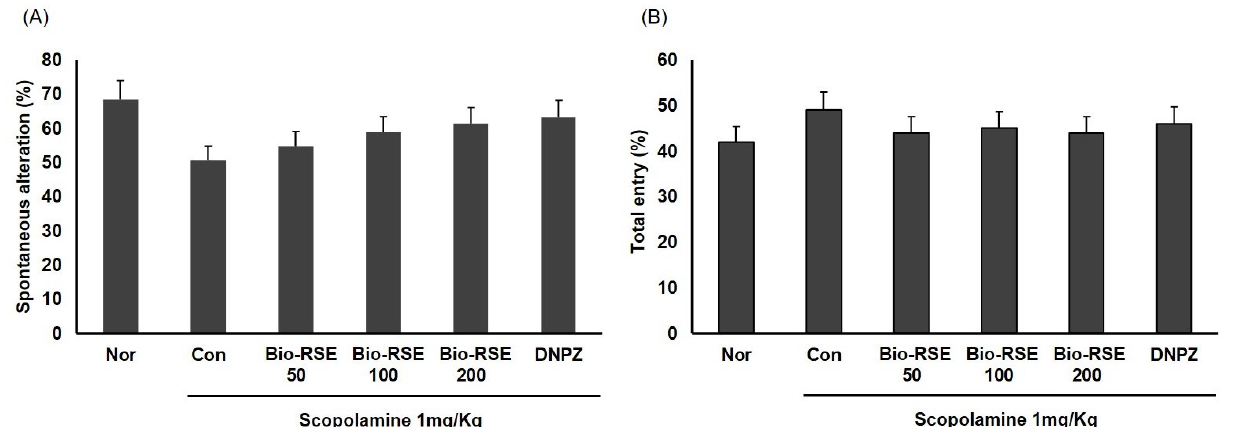
Figure 2. Effect of Bio ‐ RSE on spatial alternation in the Y ‐ maze test. Values are the mean ± SD. ( A ) The space perception abilities for the CON and Bio ‐ RSE routes were significantly different, as de ‐ termined by Student’s t ‐ test ( p < 0.05). ( B ) Total number of admissions for each experimental